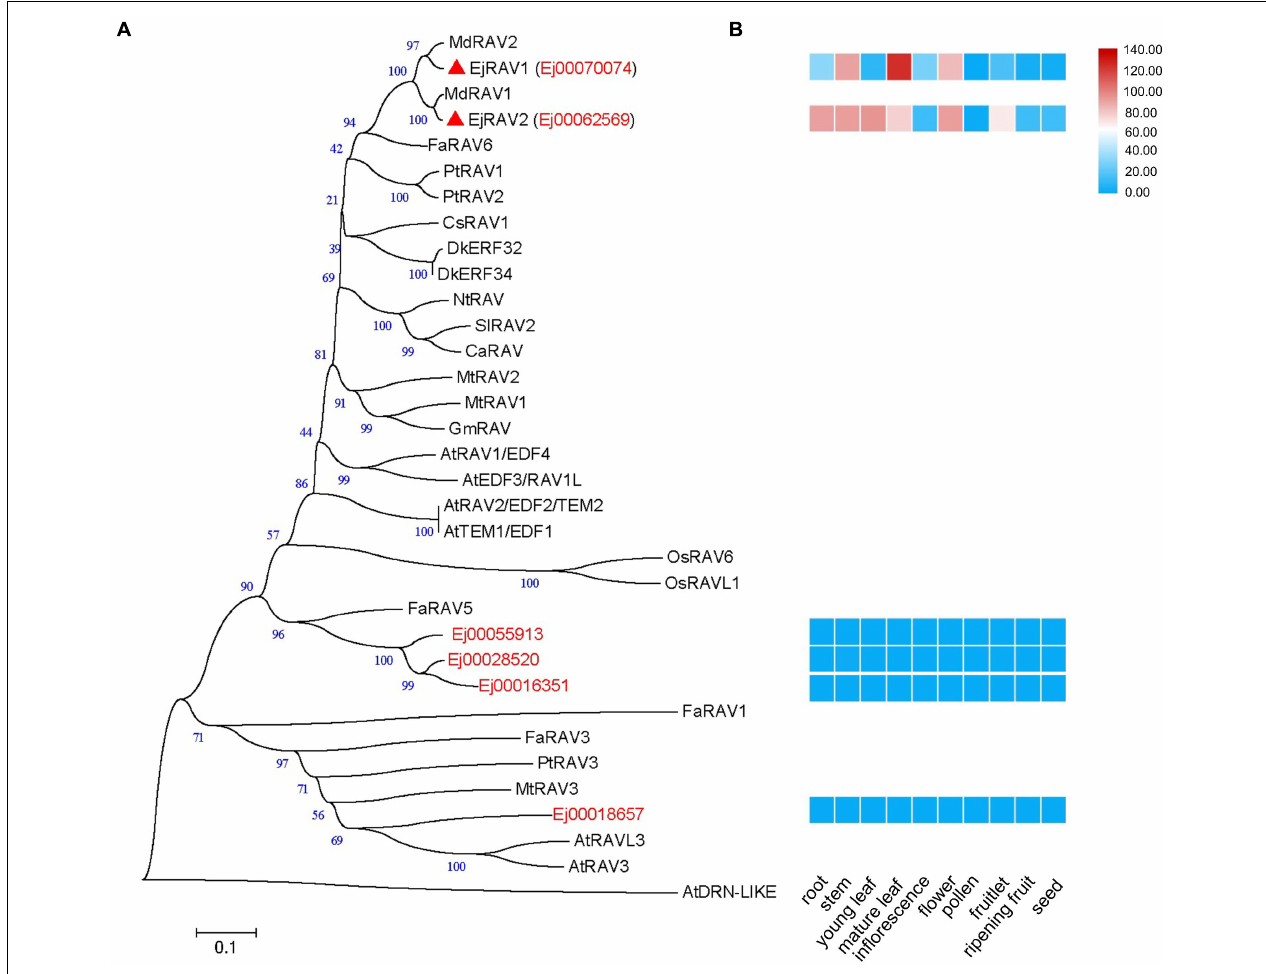
FIGURE 1 | A phylogenetic tree and expression heat map of RAV family genes in loquat. (A) A phylogenetic tree containing RAV homologs identified in loquat genome and other species. AtDRN-LIKE was selected as an outer-group. The red triangles indicate candidate RAVs that play role in the transition of reproductive phase in loquat. At, Arabidopsis thaliana ; Ca, Capsicum annuum ; Cs, Castanea sativa ; Dk, Diospyros kaki ; Ej, Eriobotrya japonica ; Fa, Fragaria ananassa ; Gm, Glycine max ; Md, Malus domestic a; Mt, Medicago truncatula ; Nt, Nicotiana tabacum ; Os, Oryza sativa ; Pt, Populus trichocarpa ; Sl, Solanum lycopersicum . (B) Tissue expression patterns of EjRAV family genes based on FPKM values from 10